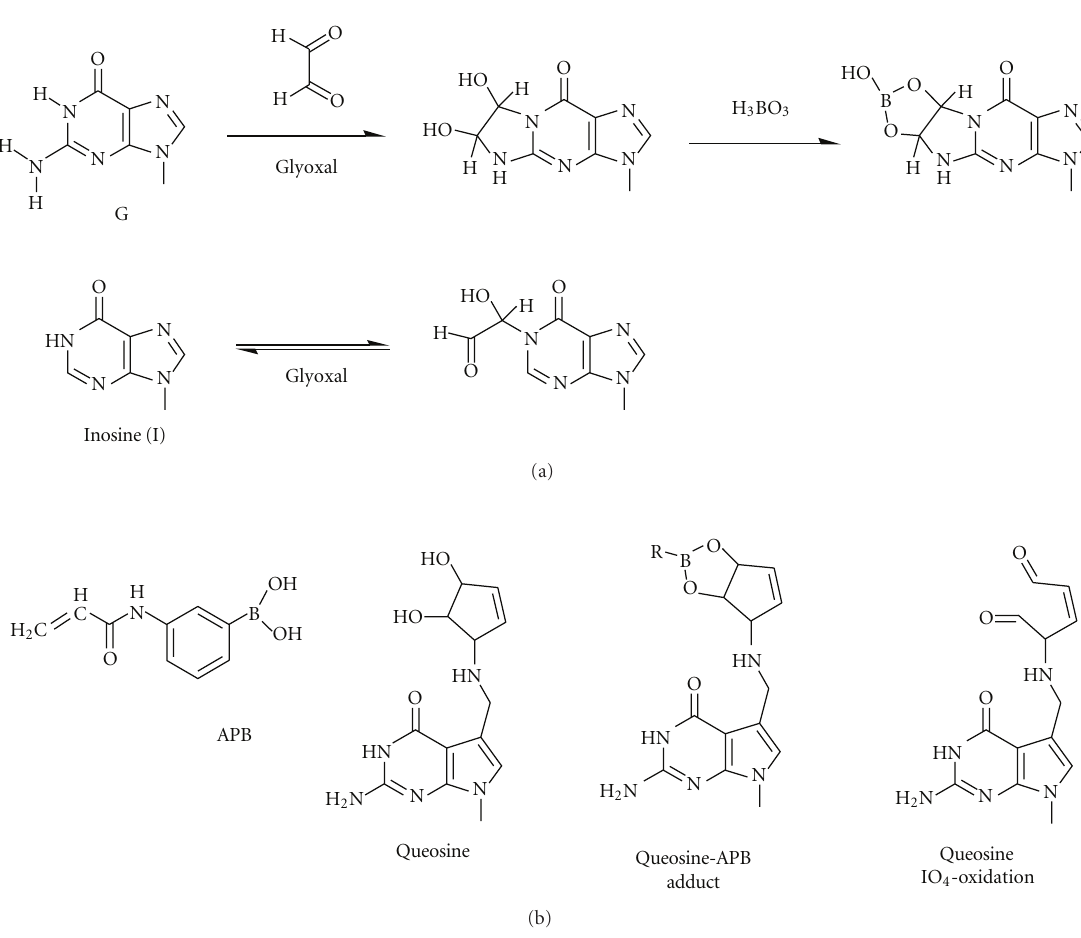
mt 6 A (m 6 t 6 A) and acp 3 U [45, 46] but may be